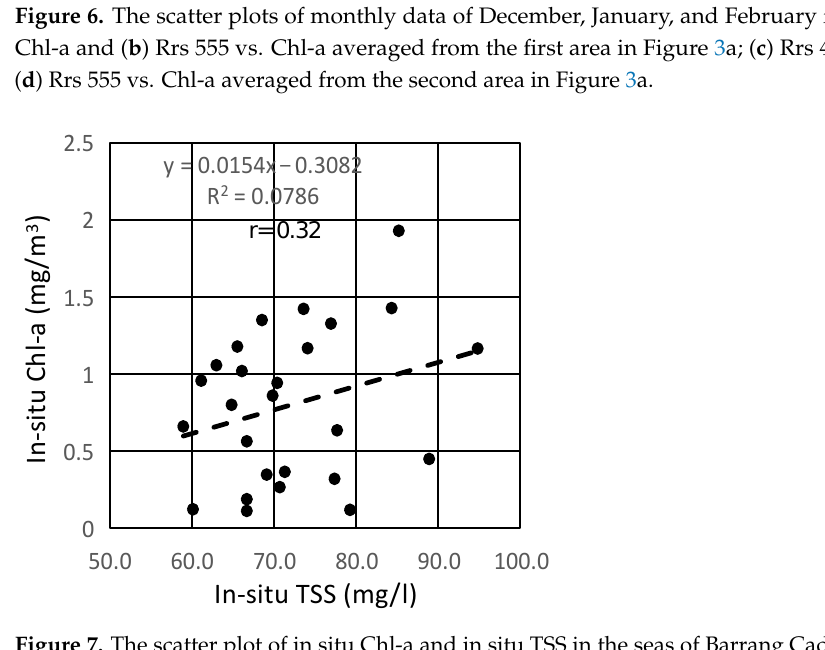
Figure 7. The scatter plot of in situ Chl-a and in situ TSS in the seas of Barrang Caddi Island (yellow dot in Figure 1c) on 8 September 2020. The value of r is for significant correlation analysis ( p < 0.05). As shown earlier, the suspended sediment in the first area is lower than that in the second area. This could be because the first area receives less precipitation than the second. Furthermore, as shown in Figure 1, the difference in land cover between areas may contribute to the varying sediment influx between the two areas. The upland